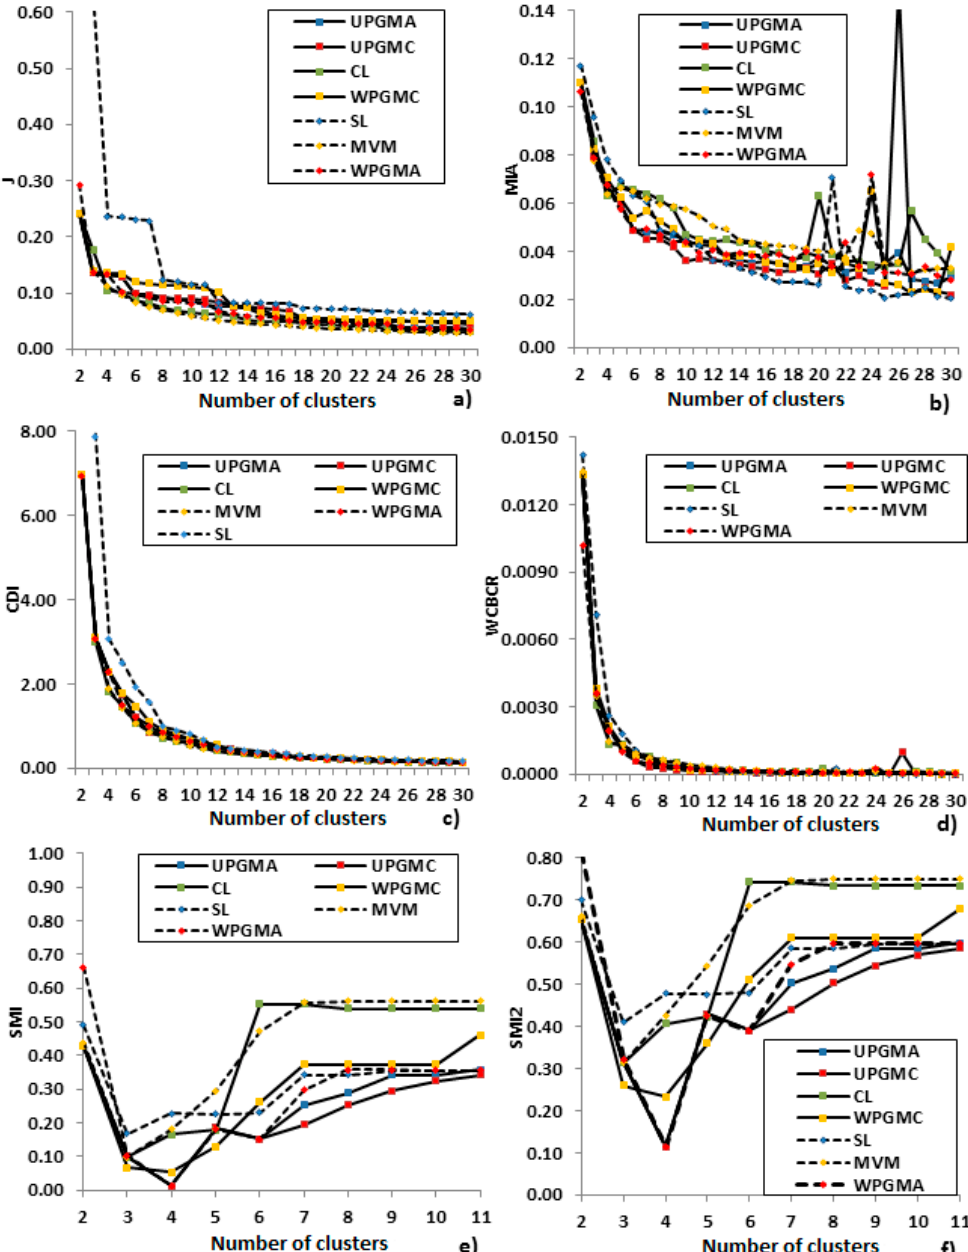
Figure 3. Comparison of the hierarchical algorithms using: ( a ) J, ( b ) MIA, ( c ) CDI, ( d ) WCBCR, ( e ) SMI, ( f ) SMI2.